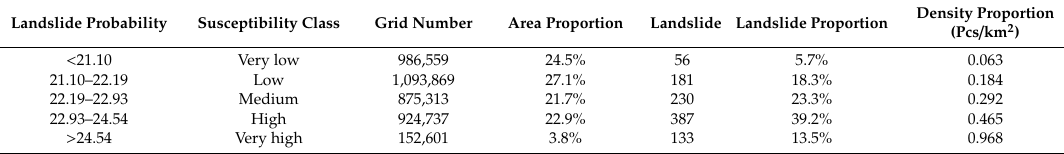
Figure 15. Landslide susceptibility map in the FR model: ( a ) Enlarged area of the valley; ( b ) Enlarged area along the river. Table 7. Statistic result of landslide susceptibility in di ff erent classes of